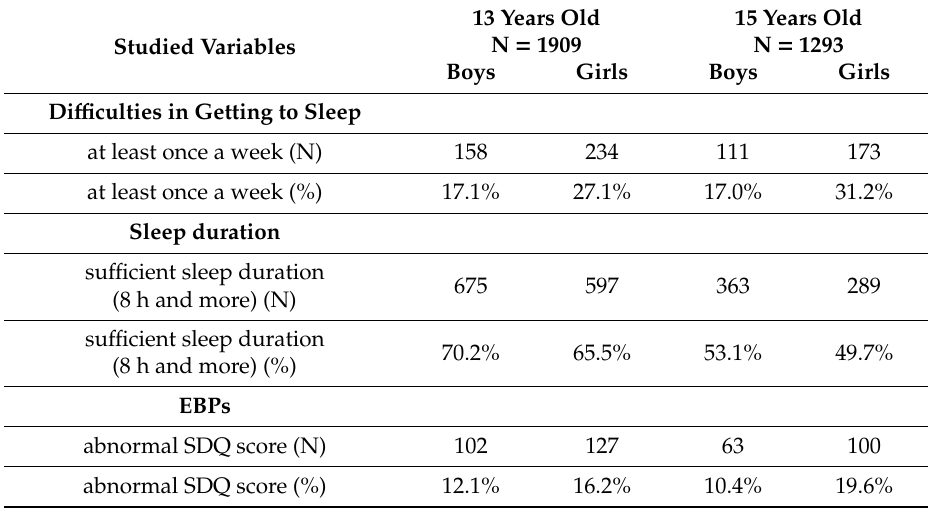
Table 1. Descriptive statistics of studied variables stratified by age and gender (Slovakia, 2018, 13- and